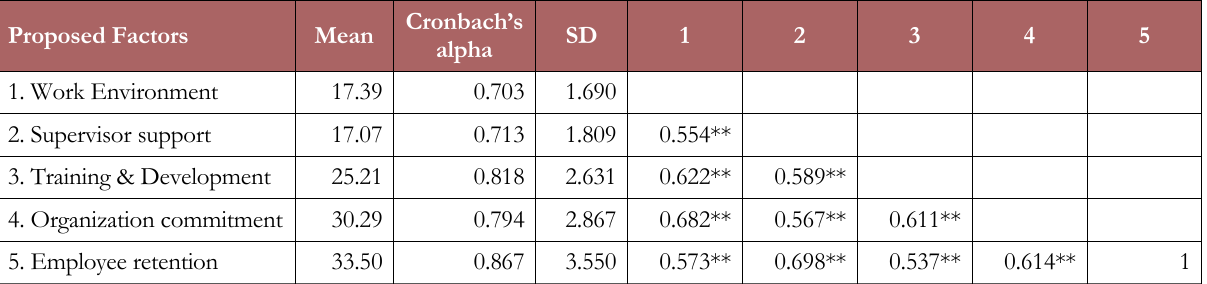
Table 1. Mean, Standard deviation and Cronbach’s alpha & correlation of proposed factors